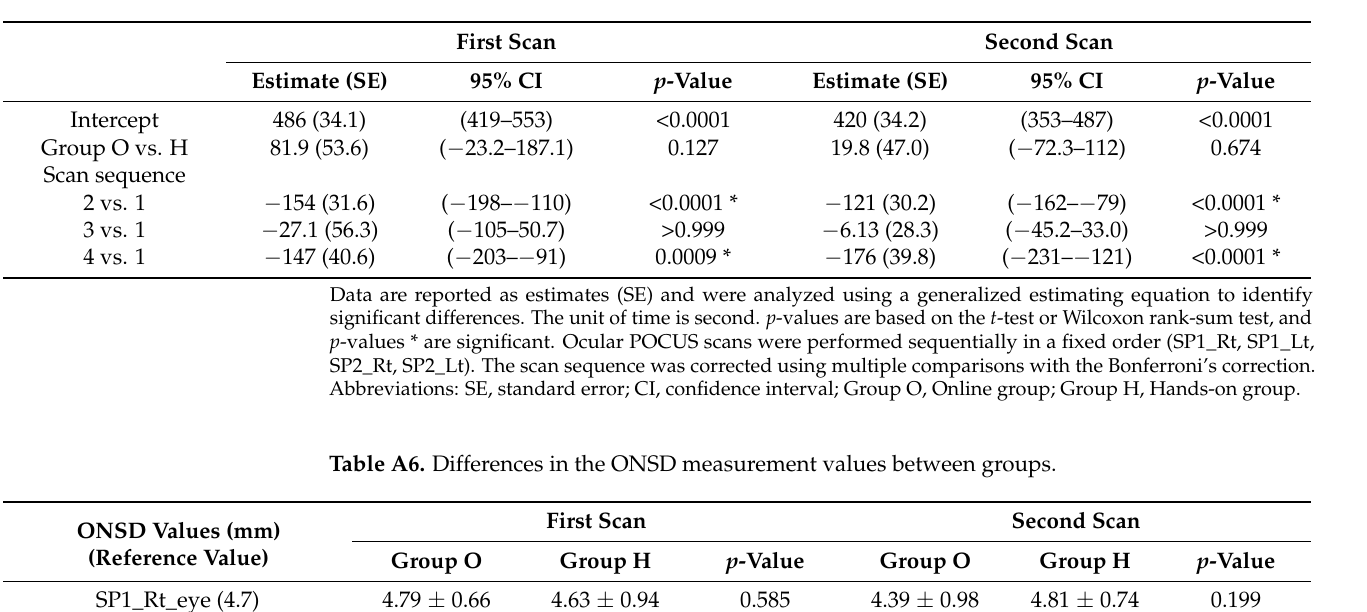
Table A5. Comparison of scan times between groups and eyes.